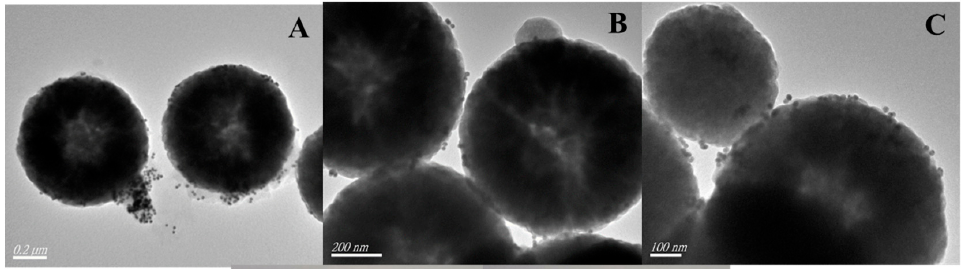
Figure 2. TEM images of Fe 3 O 4 @MPTMS@AuNPs synthesized by different volume ratios and Fe 3 O 4 @MPTMS@AuNPs. ( A ) It can be seen that there were still some AuNP particles in the composite system that were not completely bound to the surface of magnetic nanoparticles. ( B ) It can be seen that AuNPs were distributed on the surface of each magnetic nanosphere. The volume ratio of Fe 3 O 4 to MPTMS was 1:2. ( C ) It was observed that AuNPs were unevenly distributed on the surface of Fe 3 O 4 particles.